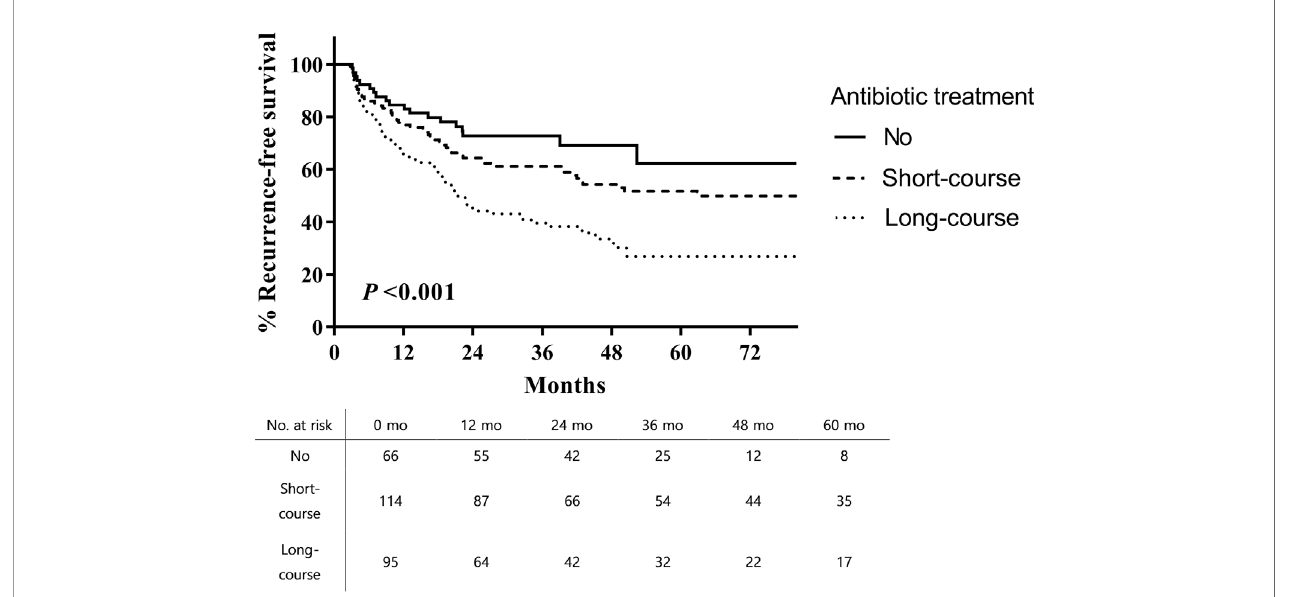
FIGURE 1 | Recurrence-free survival after intravesical BCG therapy in patients with high-risk non-muscle invasive bladder